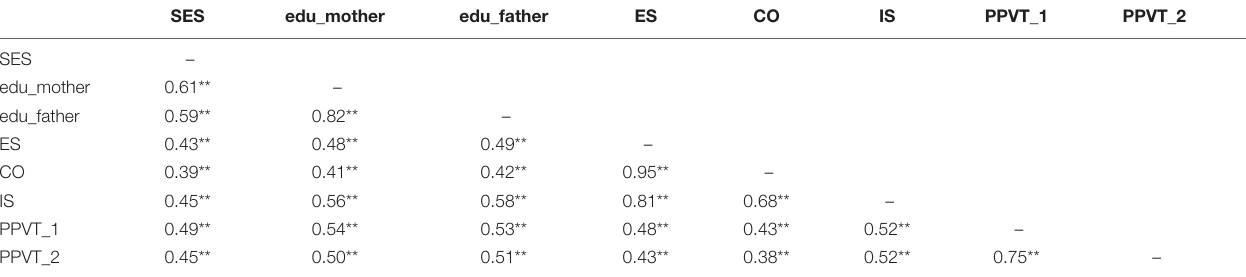
TABLE 3 | The results of correlations of teacher-child-interaction level variables and latent factors in CLASS. SES edu_mother edu_father ES CO IS PPVT_1 PPVT_2